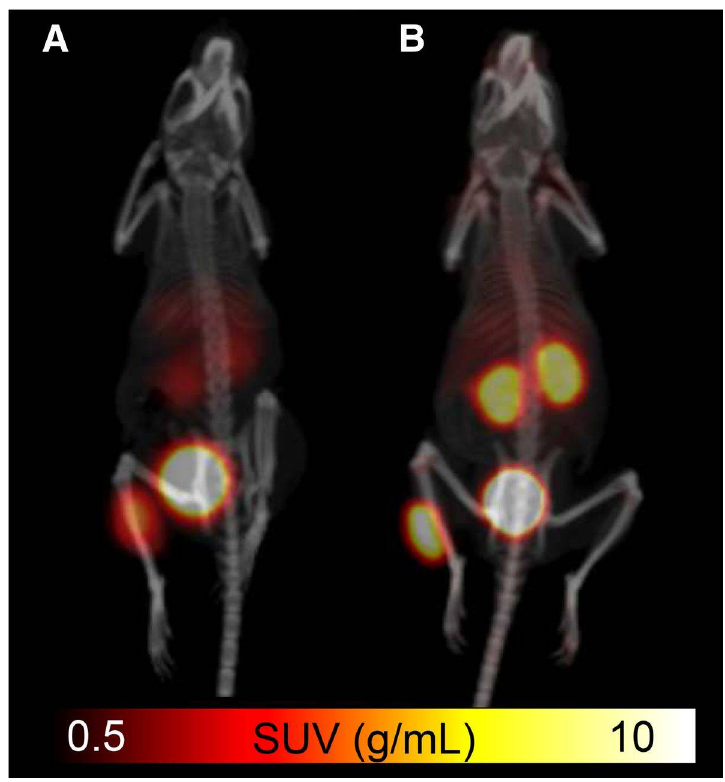
Figure 7. Comparison of ( A ) [ 68 Ga]Ga-DOTA-TATE and ( B ) [ 18 F]SiTATE in small animal PET/CT imaging with standardized uptake value (SUV) scale [37]. Reprinted with permission from Ref. [37]. Copyright 2015 SNMMI.